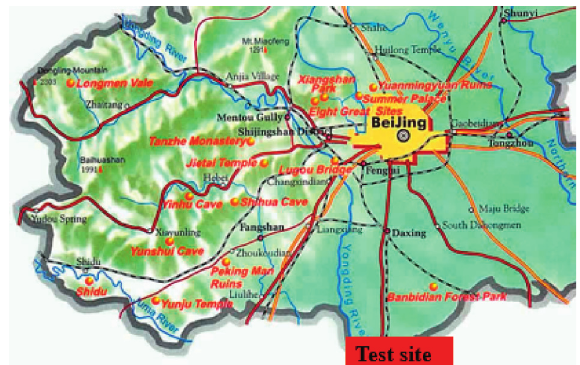
Figure 2: Location of test sites.